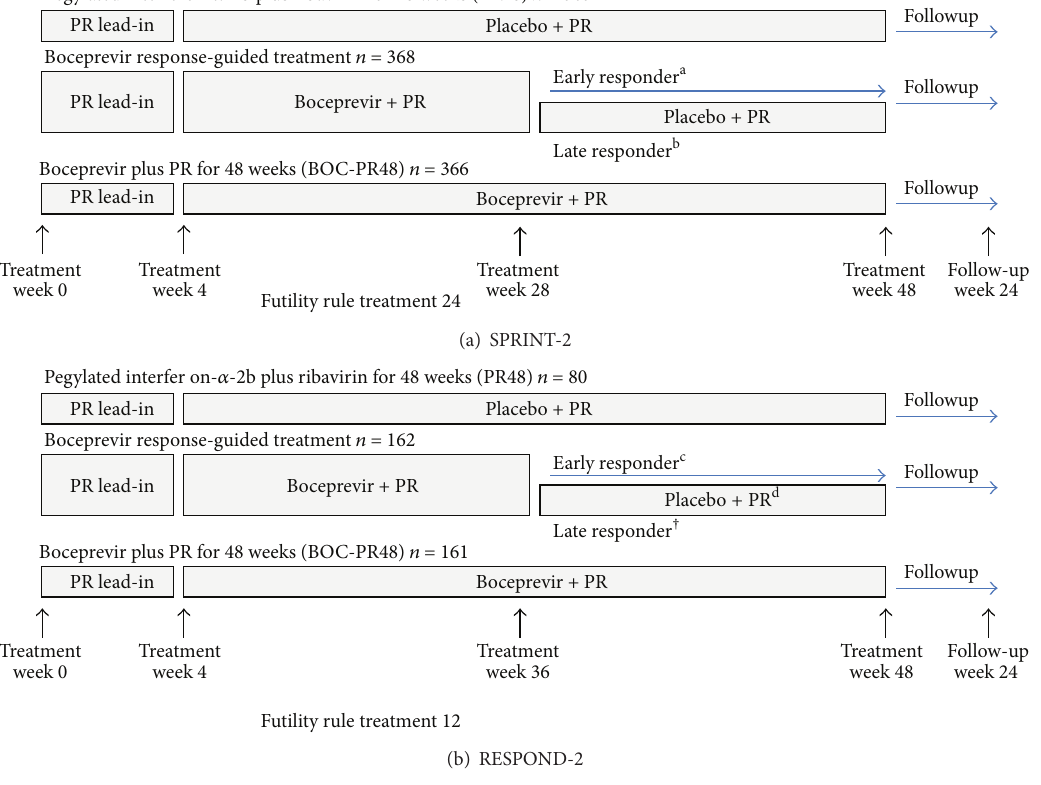
Figure2:PhaseIIItrialsofboceprevirinpatientswithhepatitisCgenotype-1infection.(a)SPRINT-2trialinpreviouslyuntreatedpatients.(b) RESPOND-2trialforpreviouslytreatedpatients;patientswerepartialrespondersandrelapsersandnull-responders.PR:pegylatedinterferon- 𝛼 -2b 1.5 𝜇 g/kg per week plus weight-based ribavirin 600–1400 mg per day. BOC: boceprevir 800 mg every 8h. a Hepatitis C RNA treatment weeks 8–24 undetectable. b Hepatitis C RNA treatment week 8 detectable, treatment week 24 undetectable. c Hepatitis C RNA treatment weeks 8–12 undetectable. d Hepatitis C RNA treatment week 8 detectable, treatment week 12 undetectable. Excerpted from Pearlman